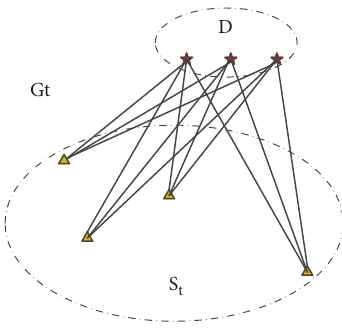
Figure 1: Bipartite graph